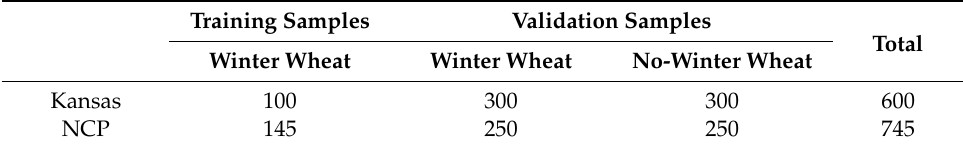
Table 2. The numbers of site-level training and verification samples for the two study